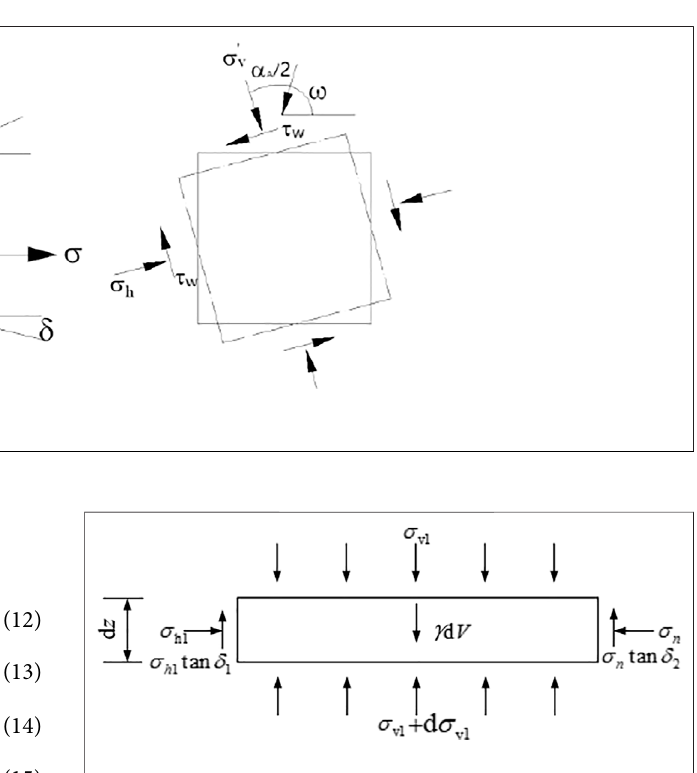
FIGURE 6 | Microelement mechanical model of Zone